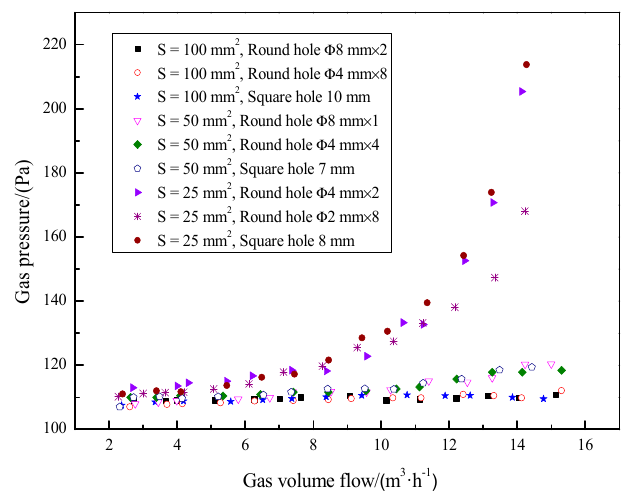
Figure 5. Change of gas pressure with gas flow rate at submergence ratio of 0.5.